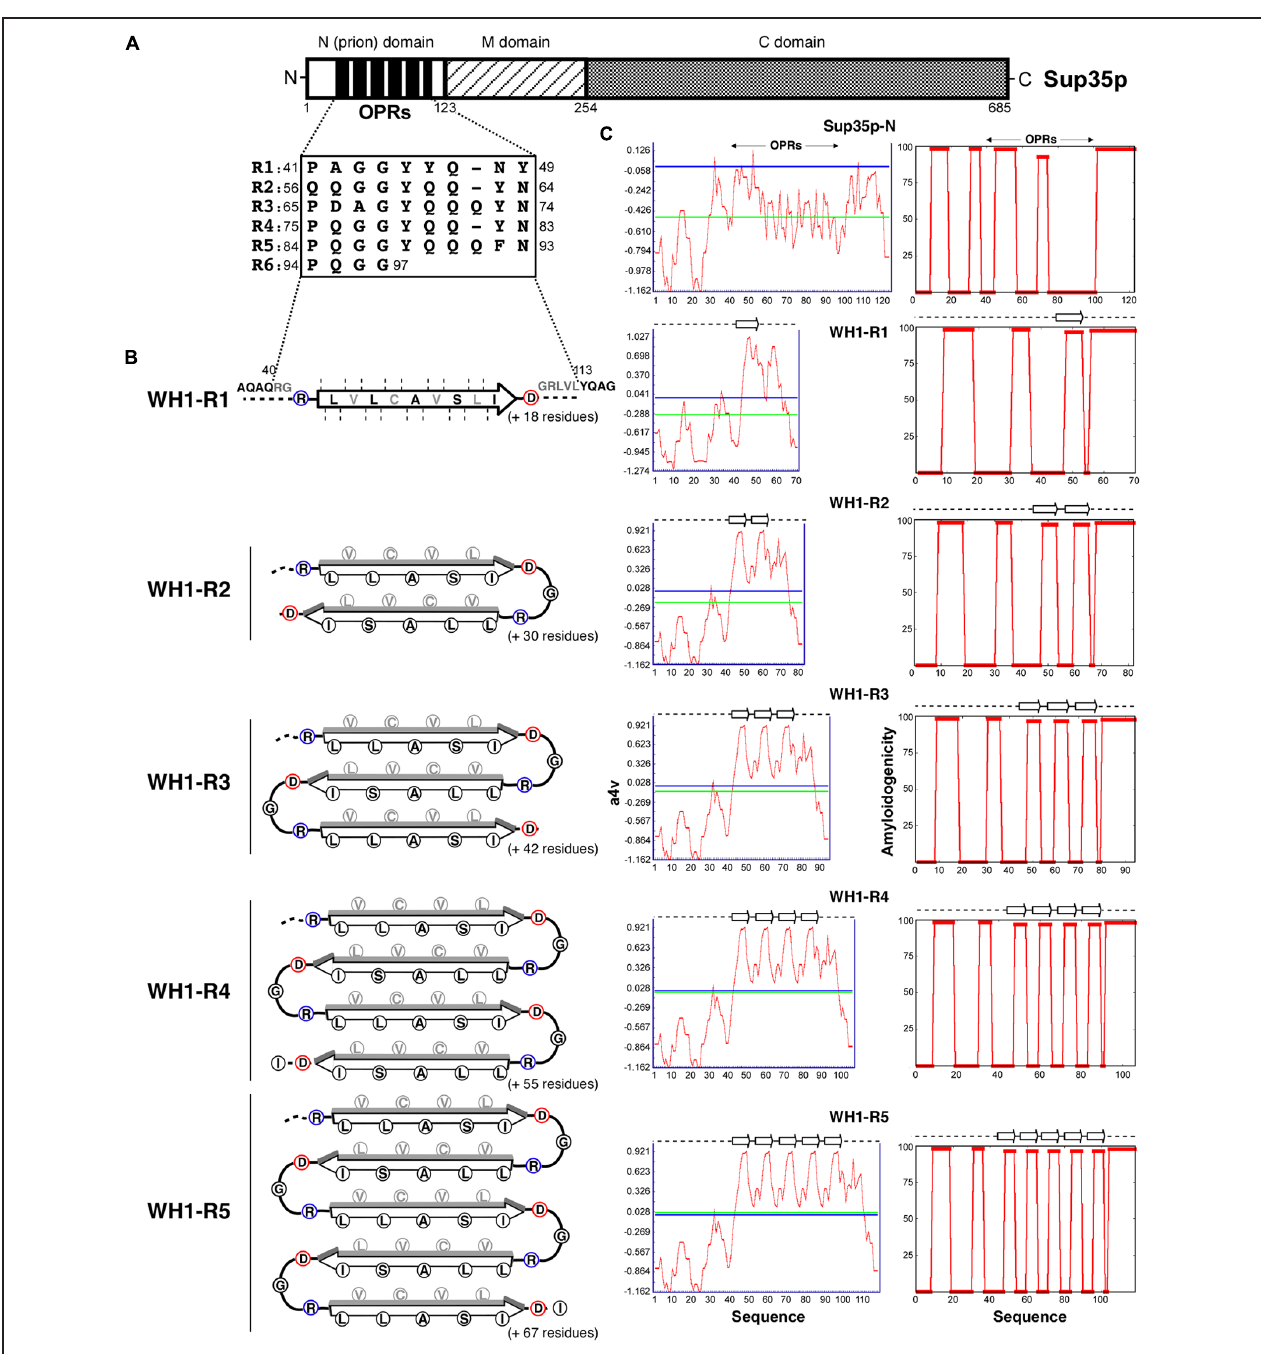
FIGURE 1 | Chimeras between the yeast prion protein Sup35p and the amyloidogenic stretch in the bacterial prionoid RepA-WH1. (A) Schematic representation of Saccharomyces cerevisiae eRF3 (Sup35p), with its domain composition and the N-terminal 5 1 / 2 OPRs highlighted. (B) The R0 + WH1-R1-5 chimeras. Sup35p OPRs were totally replaced by 1–5 tandem repeats of the hydrophobic amyloidogenic stretch in the RepA-WH1 variant A31V (arrow; Giraldo, 2007). The heterologous sequences were engineered to fold as zigzag β -arcades (reviewed in Kajava et al., 2010), in which turns were made by inserting a Gly residue between the natural Asp (blue) C- and Arg (red) ‘gatekeeper’ N-ends from contiguous WH1 repeats. β -strand packing (faces of strands in black,